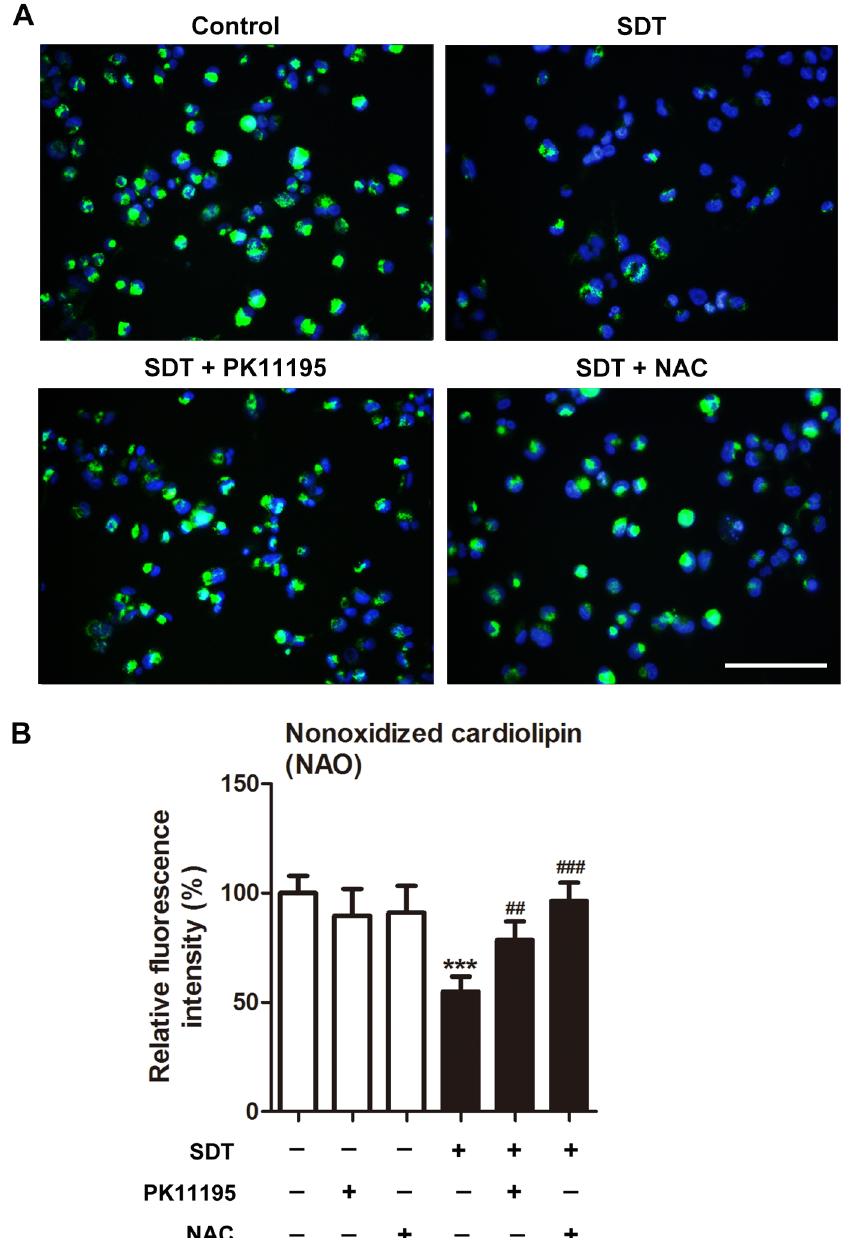
Fig 3. Effects of PK 11195 and NAC on SDT-induced cardiolipin oxidation. THP-1 macrophages were treated for 1 hours with 5-aminolevulinic acid mediated sonodynamic therapy (ALA-SDT), with or without pretreatment of PK 11195 or NAC, and cardiolipin oxidation was determined with 10- N -Nonyl-Acridine Orange (NAO). (A) Green NAO fluorescence was monitored by fluorescence microscope. Cell nuclei were stained with Hoechst. Scar bar: 0.1 mm. (B) Fluorescence intensity of NAO was measured using fluorospectrophotometer. (cid:3)(cid:3)(cid:3) P < 0.001 compared to no treatment group, ## P < 0.01 compared to ALA-SDT treated group, ### P < 0.001 compared to ALA-SDT treated group. the control group was 16.34 ± 1.88%. The SDT-treated cells displayed a 109% (34.21 ± 6.44%,